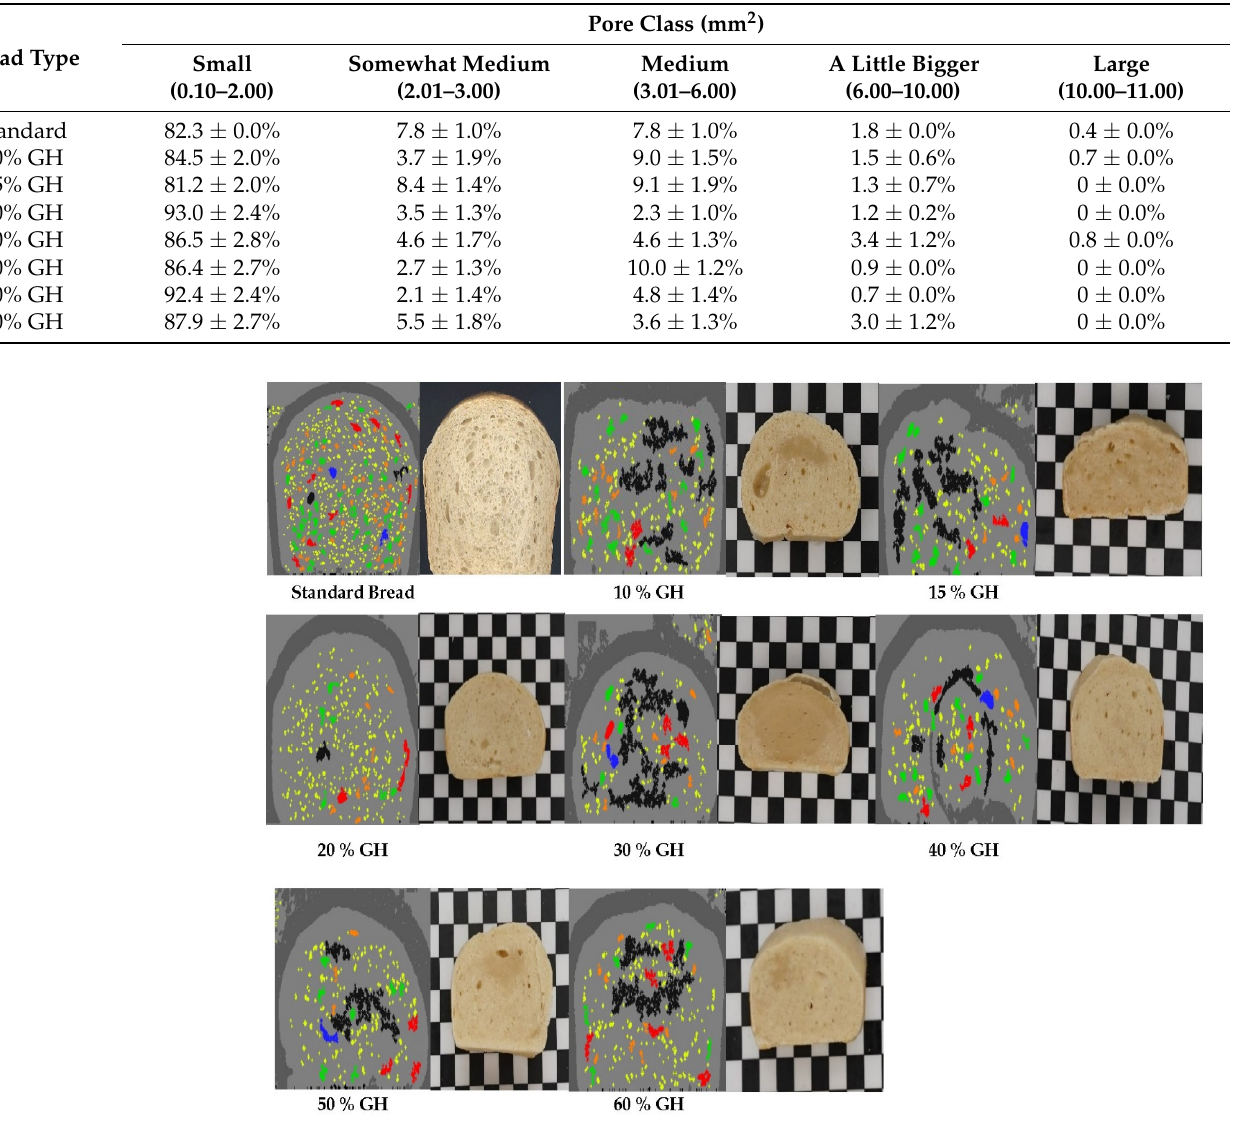
Figure 2. Pore analysis of GH bread versus the standard bread is shown. A comparative evaluation is represented in the pictures, with the left one as the pore size analysis image obtained by software, while right one as the sliced pieces of the bread taken for the pore analysis in each of the respective GH and standard breads. Table 2. Pore analysis of standard bread versus the GH bread.